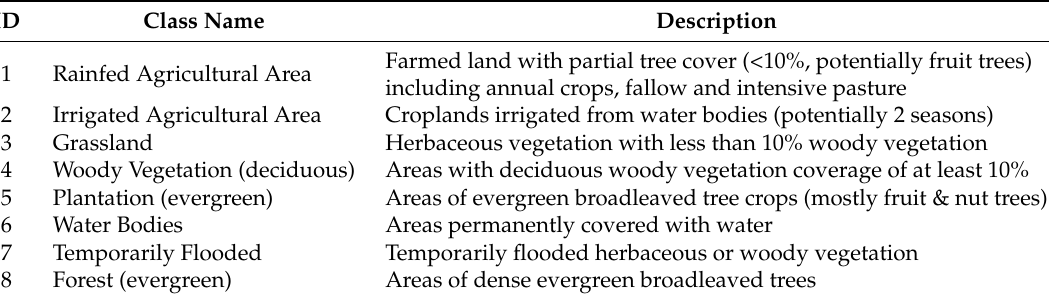
Table 1. Classification